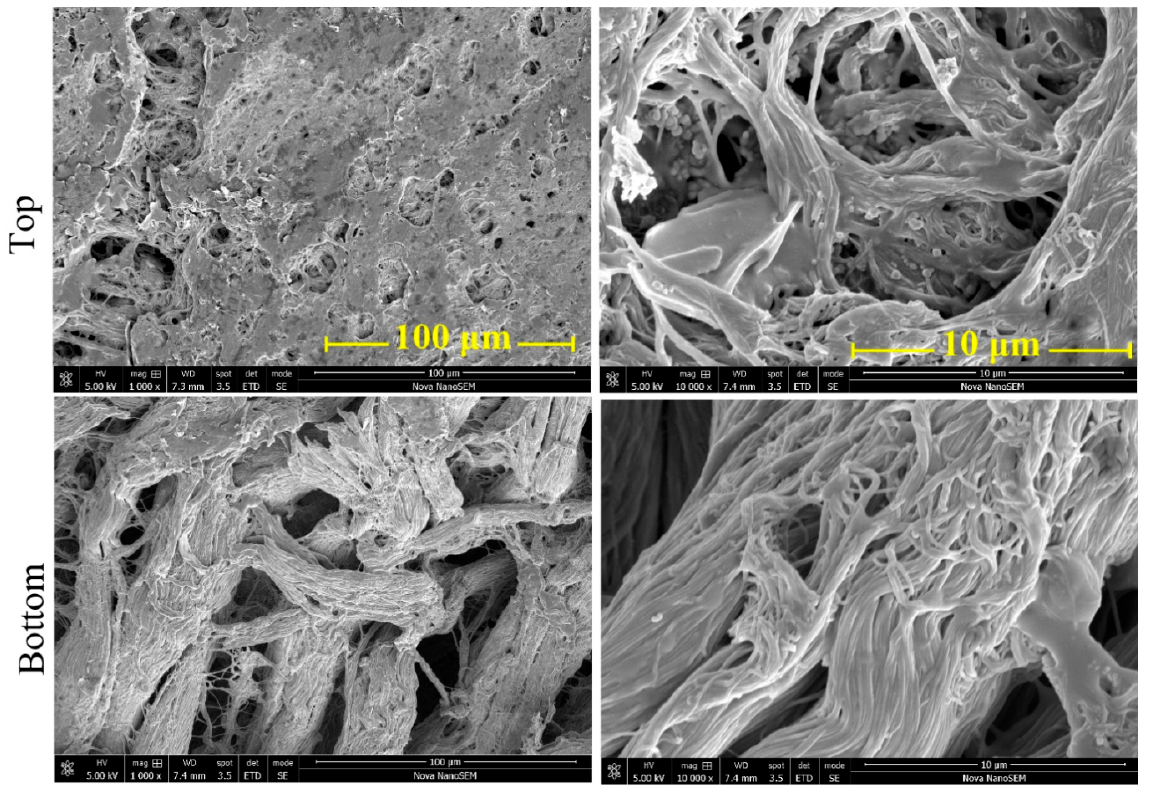
Figure 4. Surface morphology of leather coated with polypyrrole in the presence of PVP observed at two magnifications.